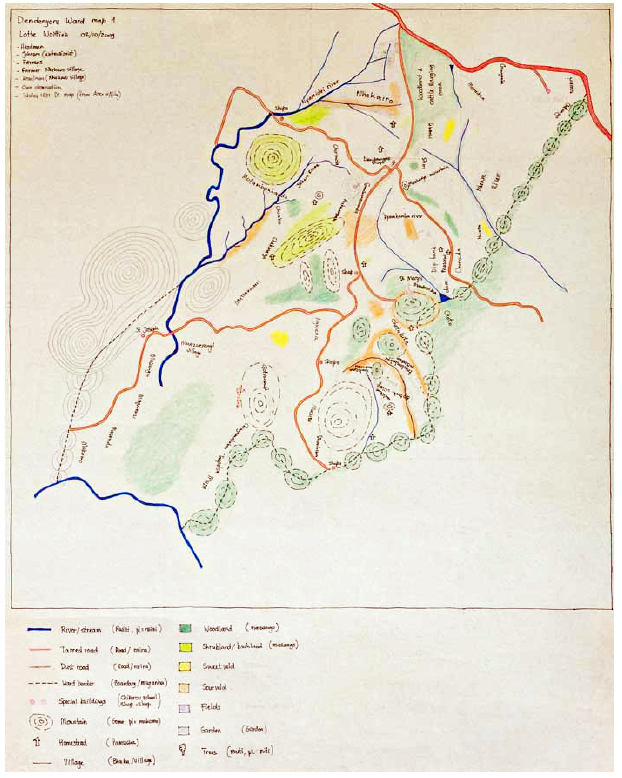
Fig. 3 . Land use map of Dendenyore ward constructed